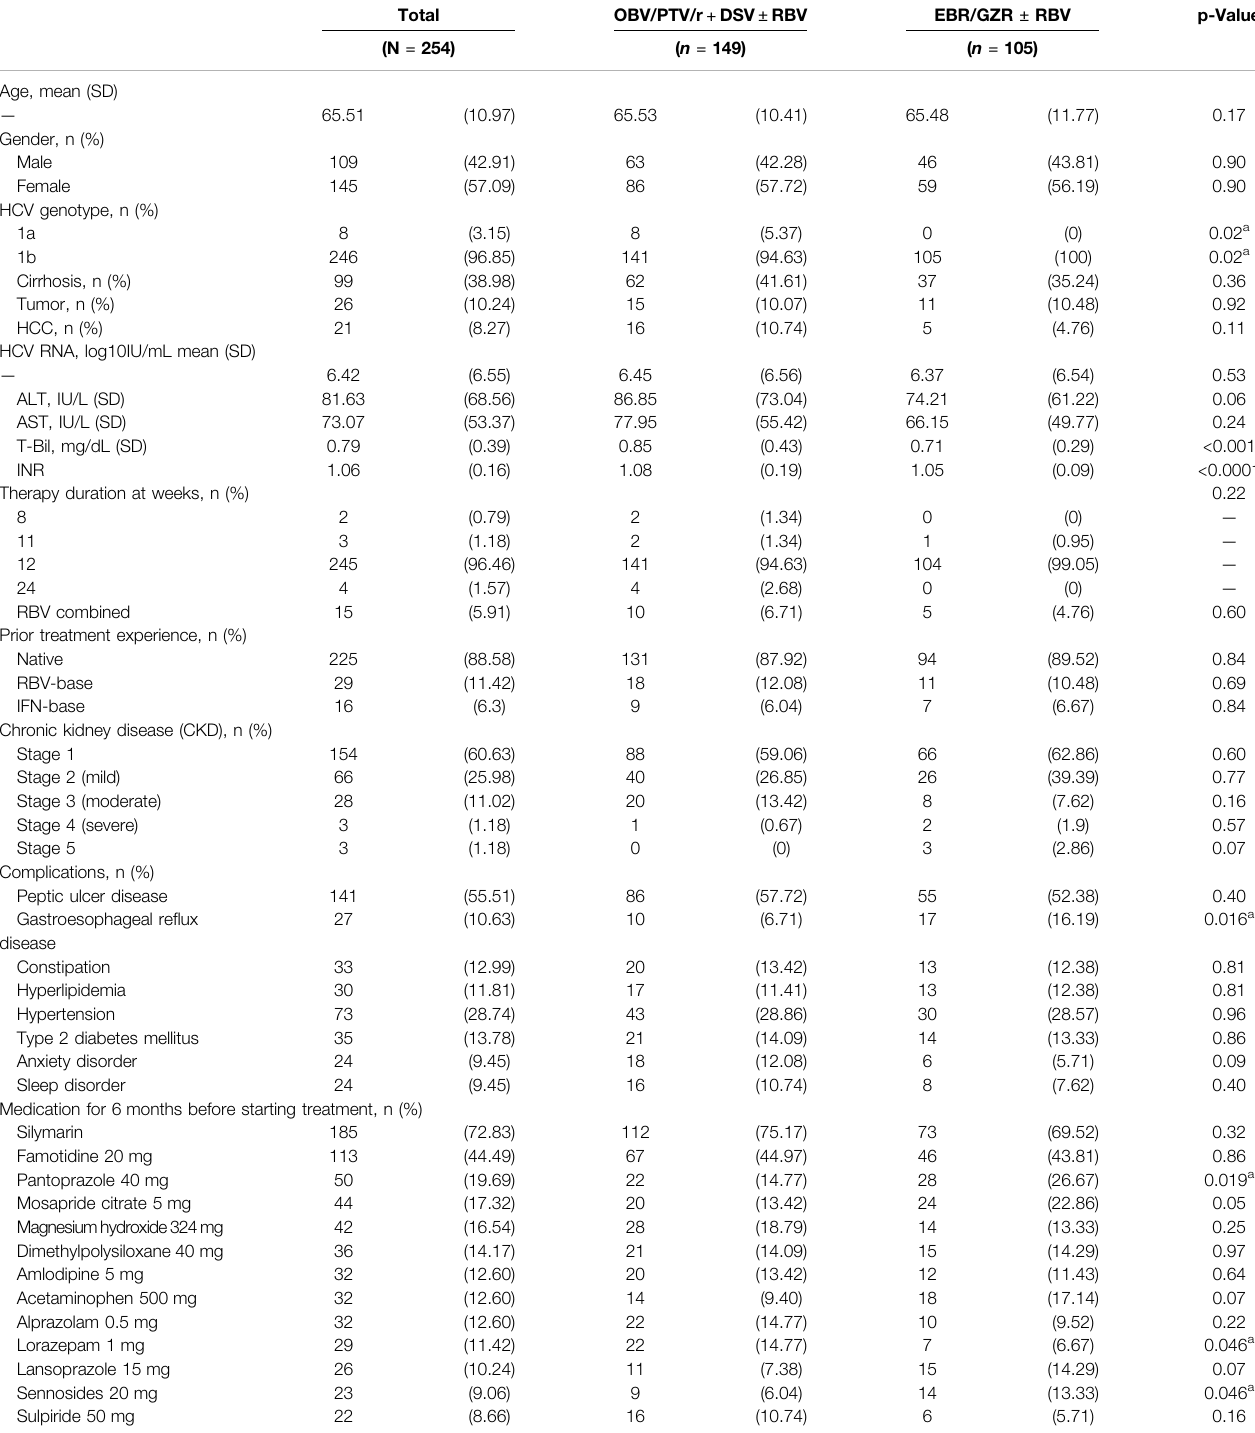
TABLE 1 | Study participants ’ baseline and demographic